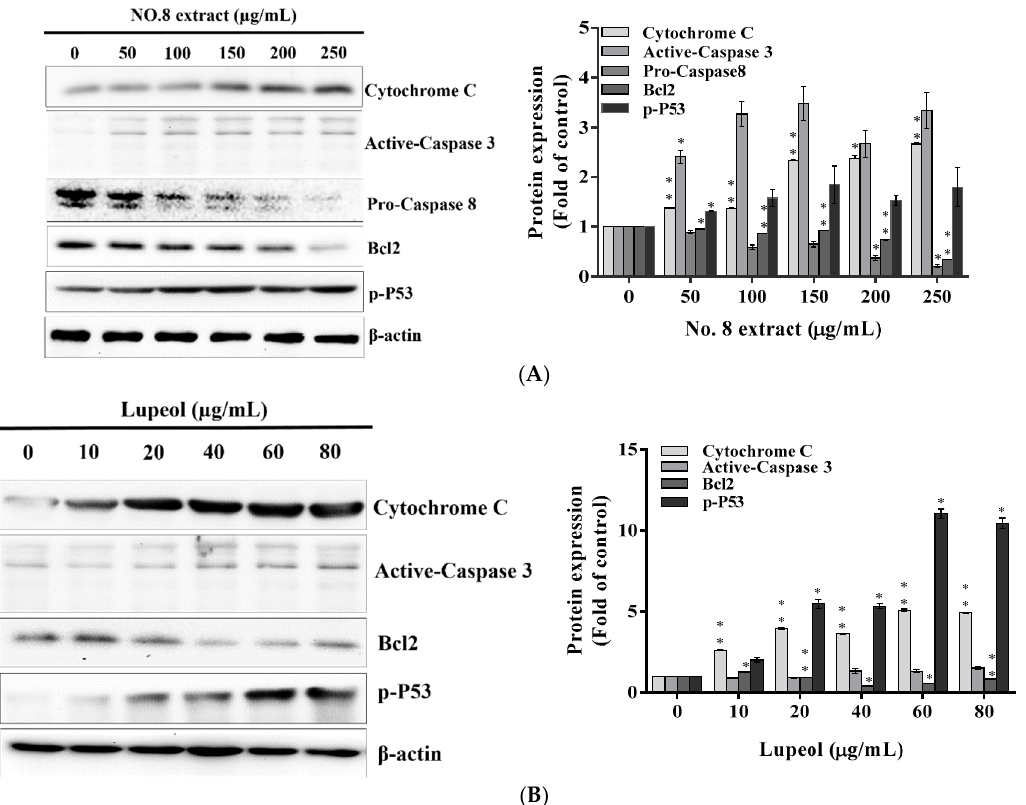
Figure 3. Regulation of apoptotic molecules by AVL ( Apocynum venetum L.) F8 on PC3 cells. The apoptotic molecules were analyzed by Western blot after PC3 cells were treated by: F8 ( A ); or lupeol ( B ). β -actin was used as an internal standard. All data are expressed as the means ± standard deviation (SD) of at least three replicates ( n ≥ 3). Statistical significance was calculated by comparing with control group. * p < 0.05; ** p < 0.01.